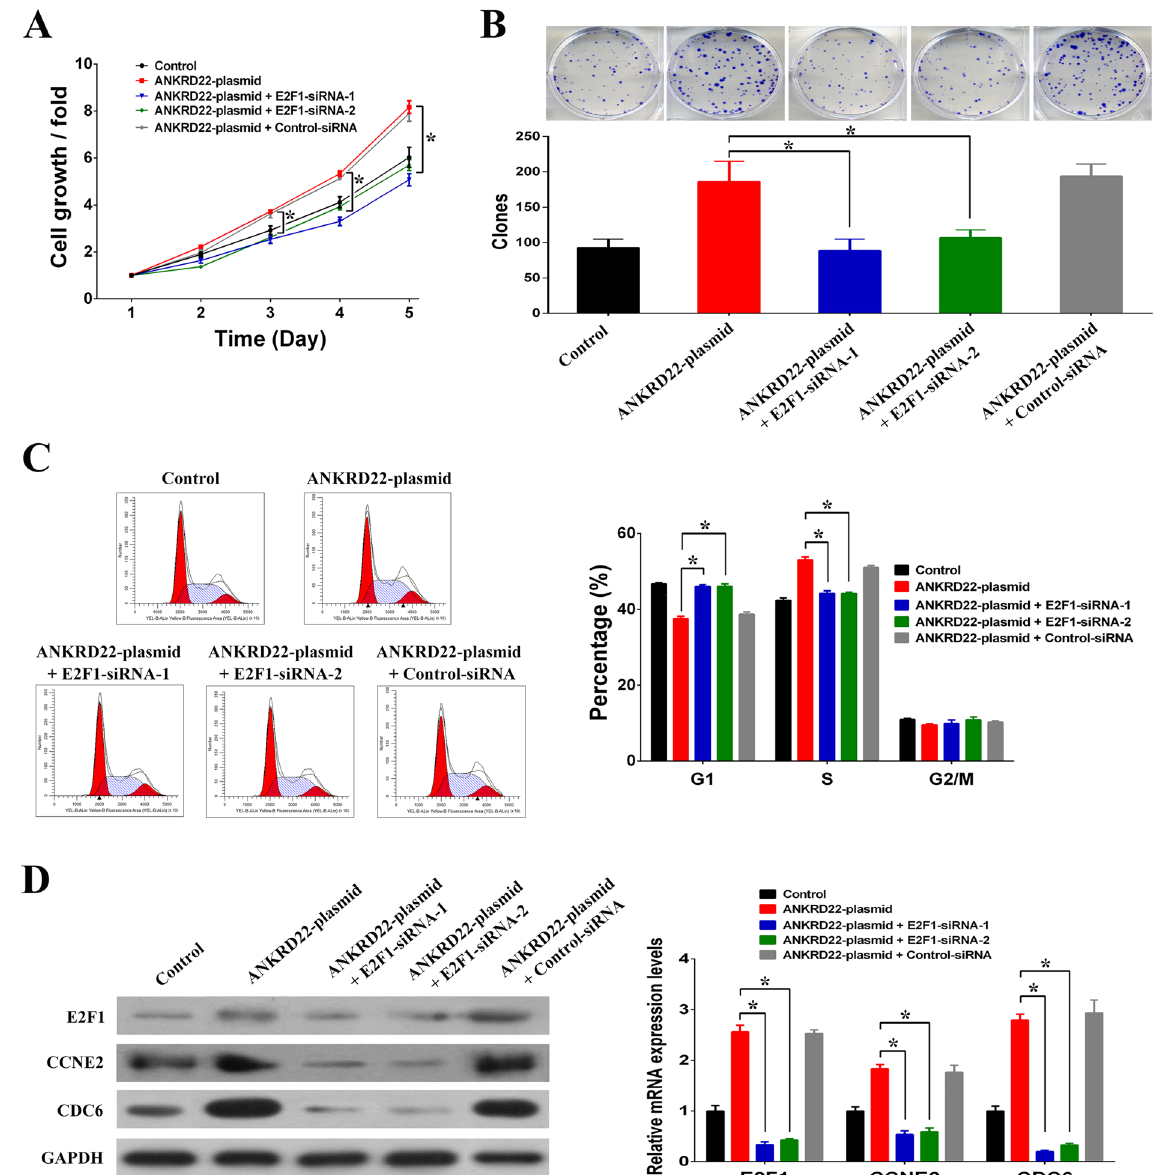
Figure 7. ANKRD22 regulated the cell cycle and cell proliferation by regulating E2F1. ( A ) Silencing of E2F1 reduced the promotion of cell growth by ANKRD22 in H1299 cells. ( B ) Silencing of E2F1 reduced the promotion of colony formation capacity by ANKRD22 in H1299 cells. ( C ) Silencing of E2F1 reduced promotion of the cell cycle by ANKRD22 in H1299 cells. ( D ) Silencing of E2F1 reduced promotion of the expression of E2F1 target genes CCNE2 and CDC6 by ANKRD22. Full-length blots are presented in Supplementary Figure S8. (n = 3, * P <